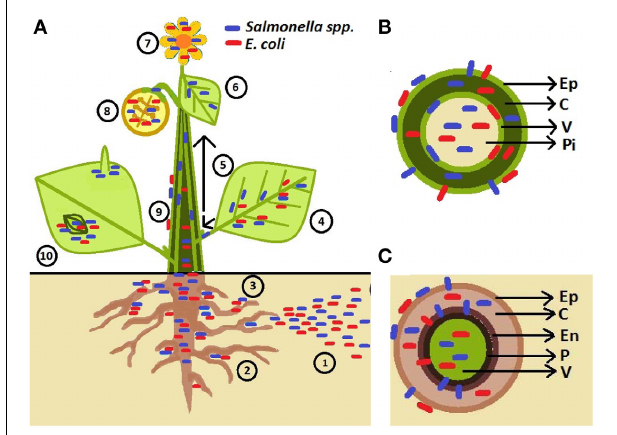
FIGURE 1 | Schematic representation of human pathogen (HP) association with plants. (A) Pathogens are introduced to soil through contaminated irrigation water, fertilizers, manure, and pesticides ( 1 ). HPs are attracted to rhizosphere ( 2 ; Klerks et al., 2007a) and penetrate root tissues at the sites of lateral root emergence, root cracks as well as root-shoot transition area ( 3 ; Cooley et al., 2003; Dong et al., 2003; Klerks et al., 2007b; Tyler and Triplett, 2008). HPs were found to live on the leaf surface near veins (Brandl and Mandrell, 2002), in the leaf apoplast (intercellular space) (Brandl and Mandrell, 2002; Solomon et al., 2002; Niemira, 2007; Kroupitski et al., 2009; Barak et al., 2011; Dinu and Bach, 2011; Gu et al., 2011; Roy et al., 2013), and sometimes with affinity for abaxial side of leaf (e.g., S. enterica ; (Kroupitski et al., 2011) ( 4 ). Salmonella enterica Typhimurium can enter tomato plants via leaves and move through vascular bundles (petioles and stems) ( 5 ) into non-inoculated leaves ( 6 ) and fruits ( 8 ) (Gu et al., 2011). HPs are also found to be associated with flower ( 7 ; Guo et al., 2001; Cooley et al., 2003). Salmonella could travel from infected leaves ( 4 ), stems ( 5 ), and flowers ( 7 ) to colonize the fruit interior (the diagram represents a cross-section of a fruit) and fruit calyx ( 8 ) Guo et al., 2001; Janes et al., 2005; Barak et al., 2011. Escherichia coli O157:H7 has also been observed in the internal parts of the apple and the seeds following contamination of the flower ( 8 ) (Burnett et al., 2000). Movement on the plant surface has also been observed ( 9 ; Cooley et al., 2003). Epiphytic Salmonella and E. coli O157:H7 can aggregate near stomata and sub-stomatal space ( 10 ; Shaw et al., 2008; Berger et al., 2009a,b;